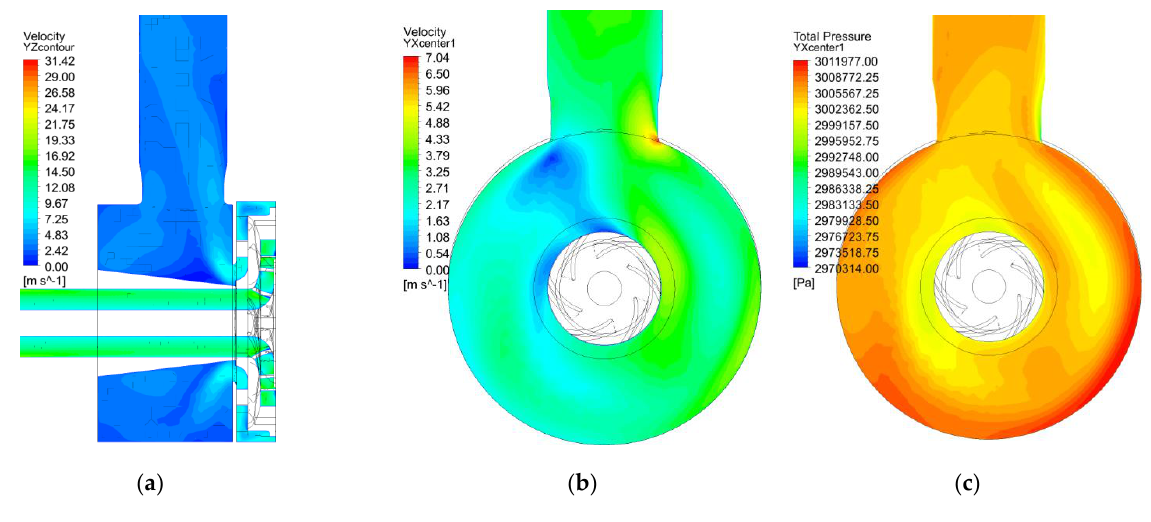
Figure 6. Qualitative picture of the distribution of relative velocity in the ring chamber ( a ) and in the pressure nozzle of the outlet device ( b ); pressure in the ring chamber and the discharge nozzle of outlet device ( c ).